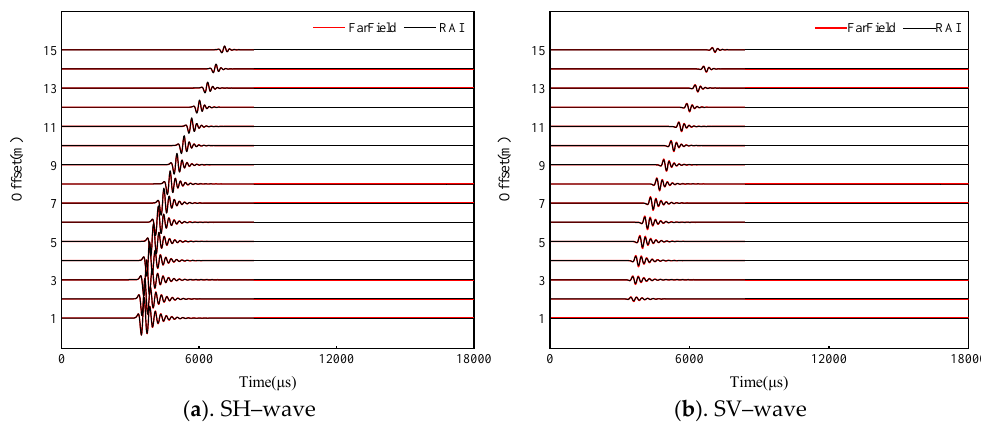
Figure 2. Far-field displacements of SH–wave and SV–wave obtained by the exact solution and the far-field asymptotic solution with the source frequency of 3 kHz in the medium formation.